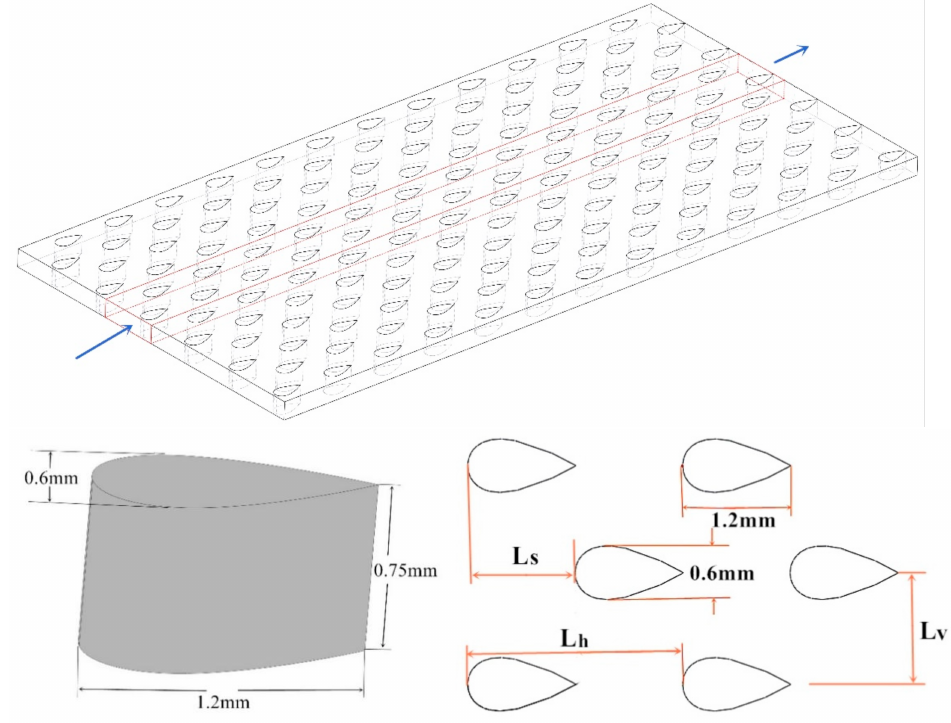
Figure 1. Schematic diagram of internal core structure of airfoil fin PCHE. The NACA0050-4.5/2.6 airfoil (the airfoil relative maximum thickness as a percentage of the chord is 50%, the leading-edge radius index is 4.5 and the chordwise-position of airfoil maximum thickness is 26%) is used as the shape of the fin. The symmetrical airfoil fins are defined by the fin height (H), fin width (W) and fin length (L), which are set to 0.75 mm, 0.6 mm and 1.2 mm, respectively, as shown in Figure 1. The different fin structures and arrangements of the channel do not increase the processing cost. Figure 1 further shows the flow channel with airfoil fins and different distances between the airfoil fins (L s , L v , L h ). The L s presents staggered pitch, L v indicates the vertical pitch of the adjacent rows and L h indicates the horizontal pitch of the adjacent fins. The height of the flow channel in the model is 0.75 mm and the length is 400 mm, which is consistent with the height and length of the experimental heat exchanger. Figure 2 shows the boundary conditions of the 3-D model. The inlet temperature was 103 K, the mass flow rate at the inlet ranged from 0.0003461 kg/s to 0.0004384 kg/s, and the inlet pressure was set at 6 MPa. The outlet was the pressure outlet, the left and right sides were periodic, and the upper and lower sides were set as constant heat